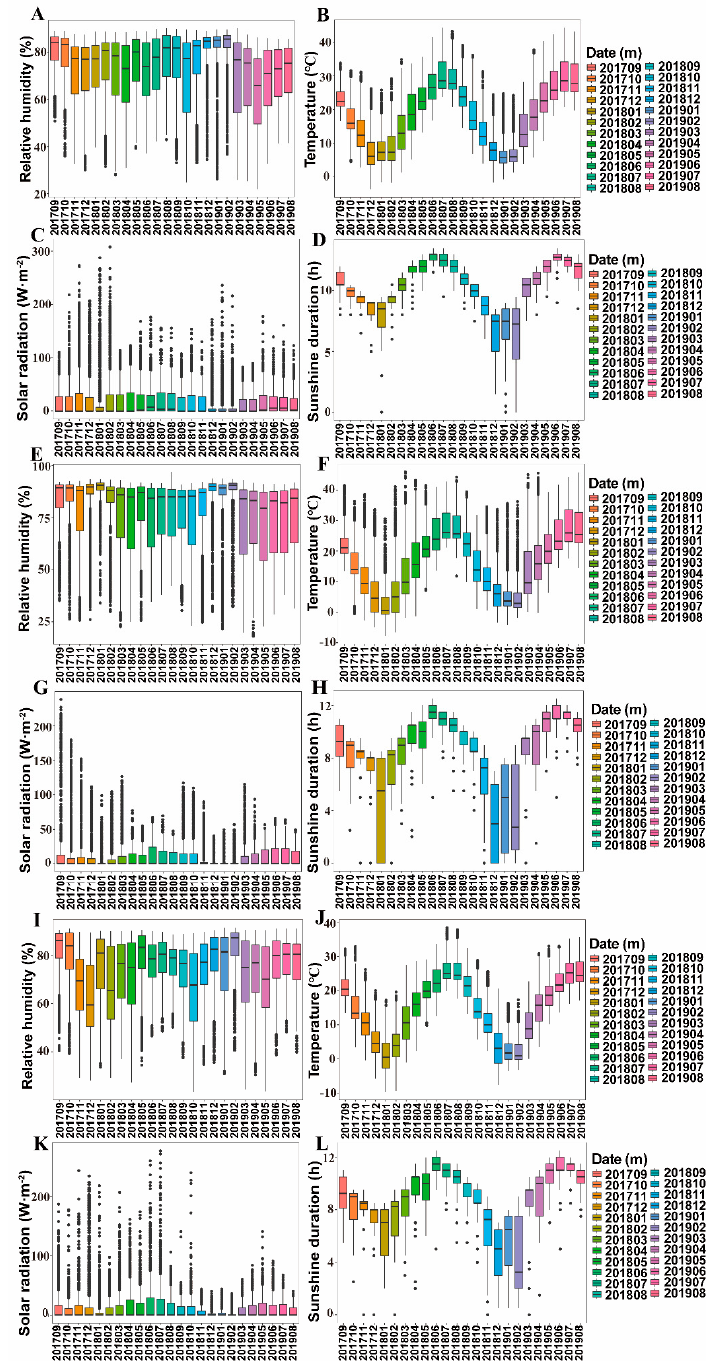
Figure 4. Climate factors under di ff erent cultivation modes. ( A – D ): Greenhouse cultivation mode; ( E – H ): Bionic cultivation mode; ( I – L ): Wild cultivation mode. Each box plot represents 1440 replicates, the inner line shows the median, the notches represent the bootstrapped 95% confidence interval of the median, the ends of the box represent the first and third quartiles and the dots represent